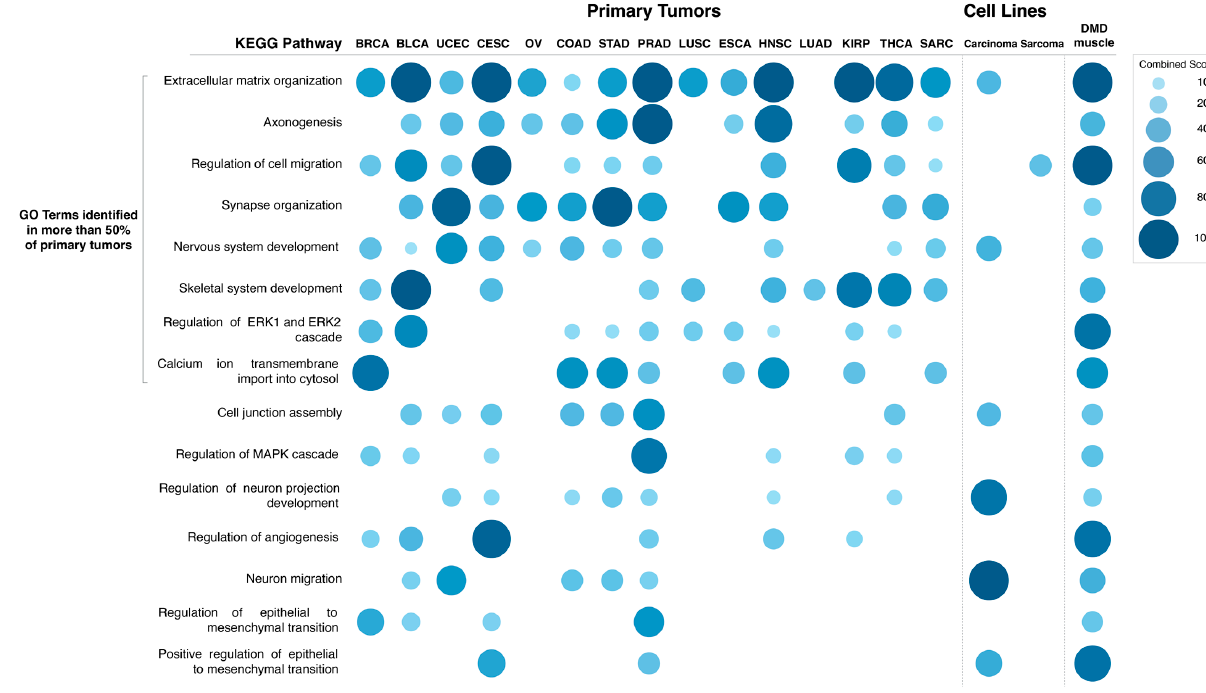
Figure 7. GO Biological Process terms enriched in the DEGs in primary tumor samples and tumor cell lines with low vs. high DMD gene expression as well as in DMD skeletal muscle (adjusted p -Value < 0.05). Data is represented as the combined score for the enrichment ( − Log ( p -Value) × odds ratio). Combined score values greater than 100 were given a value of 100.